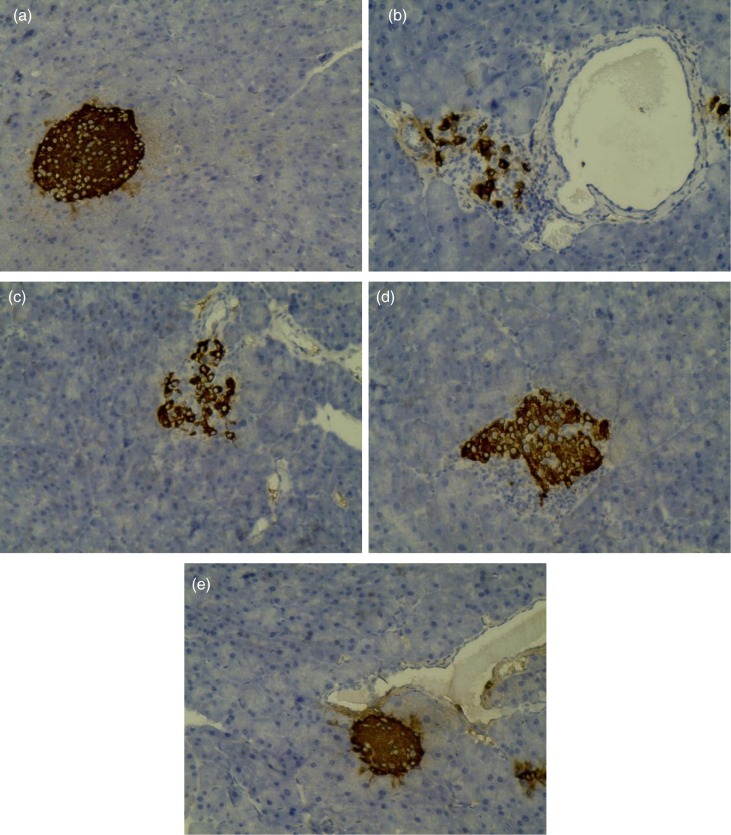
Insulin immunohistochemistry of pancreas in mice (×400). The graphs were representative of the 10 mice in each group. (a) normal group; (b) model group; (c) 2.5% MBBP-fed group; (d) 5.0% MBBP-fed group; (e) 10.0% MBBP-fed group.